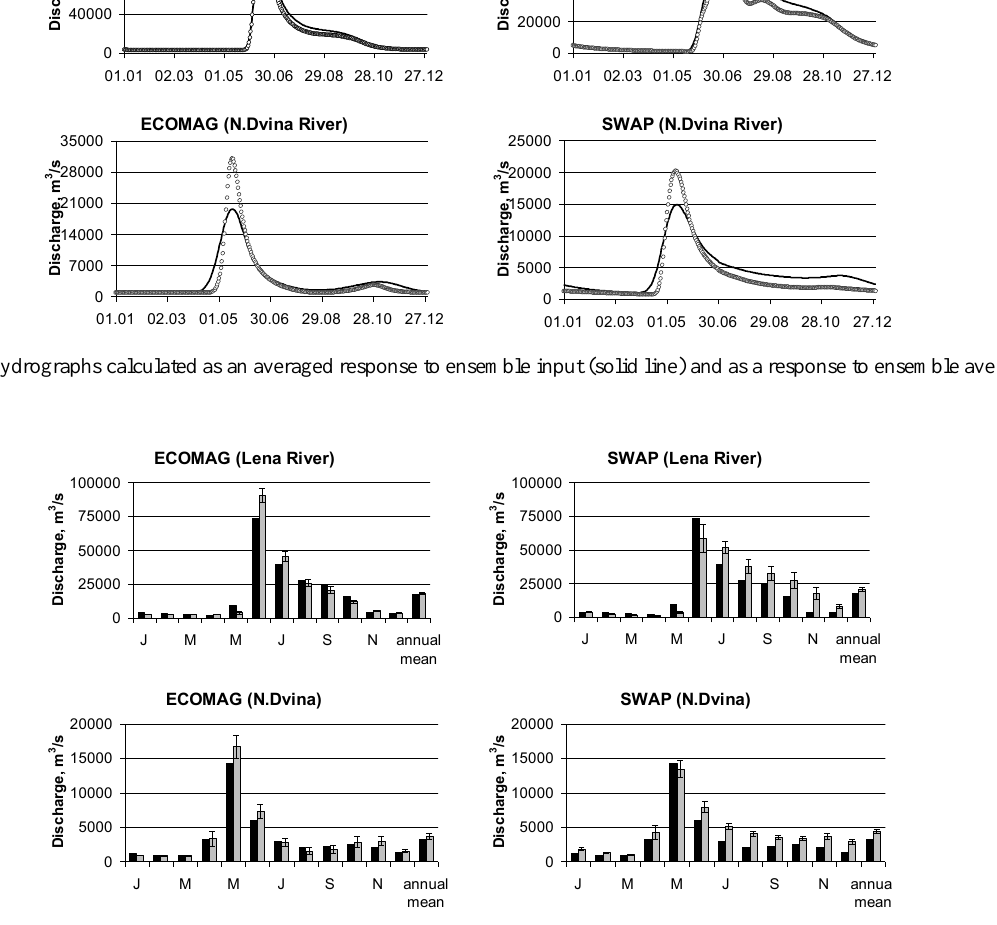
Figure 6. M estimates of annual and monthly discharges at the outlets of the Lena River (top panels) and the Northern Dvina River (bottom panels). Black columns show estimates obtained from the observation data for 1979–2009. Gray columns show estimates obtained from the ensemble simulation (with indicated 95% confidence intervals γ M for these